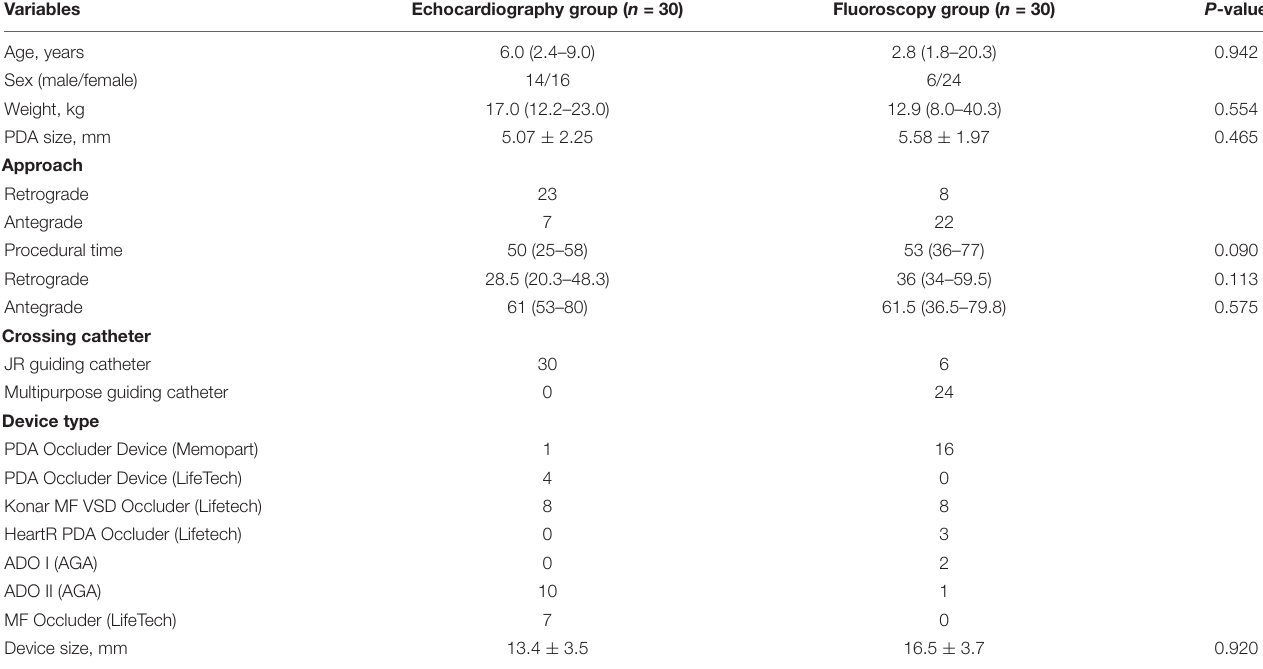
TABLE 1 | Summary of baseline characteristics of patients and procedures. Variables Echocardiography group ( n =